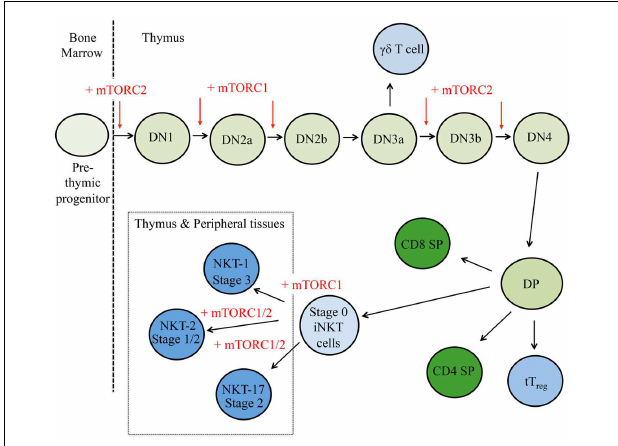
FIGURE 2 | mTOR is a critical regulator of thymocyte development . T cell progenitors first develop within the bone marrow and migrate to the thymus. Here, cells respond to multiple environmental stimuli and progress through CD4 − CD8 − double negative (DN) stages 1–4 to the double positive (DP) stage.These DP thymocytes will then adopt different cellular fates in response to additional cues. Red arrows indicate where mTORC1 and/or mTORC2 control thymocyte fate decisions, where plus signs ( + ) represent positive regulation and minus signs ( − ) depict negative